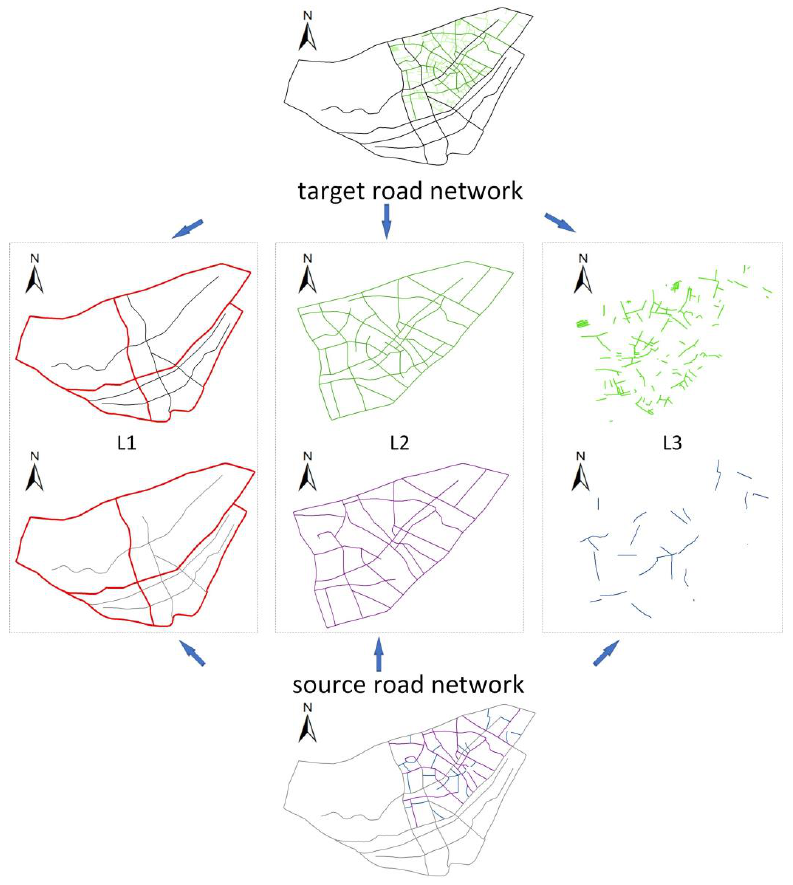
Figure 2. An example of hierarchical generation of a road network.